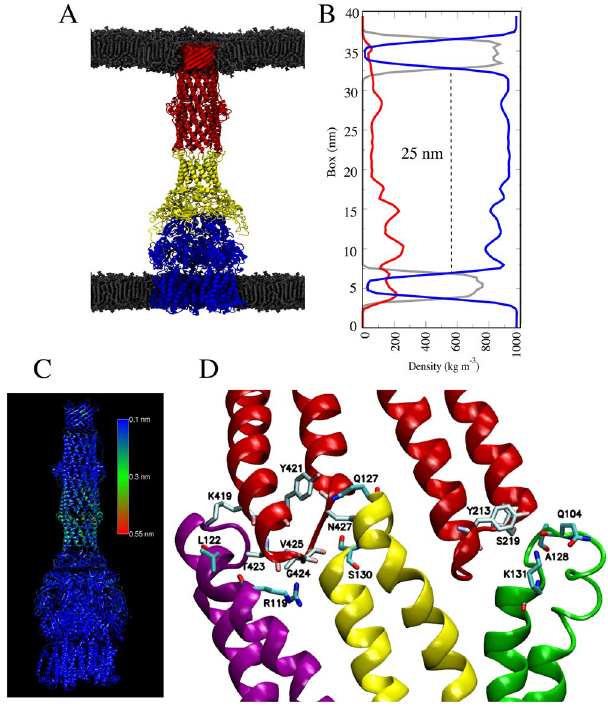
Figure 2. Molecular dynamics simulation of the fully assembled MexAB-OprM efflux pump. ( A ) The tripartite pump (red: OprM, yellow: MexA, blue: MexB) was embedded in two POPC bilayers (gray lipids) to mimic the double membrane bilayers of Gram-negative bacteria. For clarity, water molecules are not shown. ( B ) Mass density profile of the simulated system highlighting the peaks corresponding to the protein structure (red), the POPC lipids (gray), and the water molecules (blue). The density highlights the thickness of the periplasmic region as denoted by the distance between the phosphate groups of the corresponding inner leaflets (25 nm). ( C ) Root mean square fluctuations (RMSF) of the backbone atoms of the whole pump, highlighting higher fluctuations in the contact region between the periplasmic and the outer membrane domains. Fluctuations mostly range between 0.2 and 0.4 nm. ( D ) Close-up of the residues interacting between the periplasmic adaptor and outer membrane proteins during the MD simulation. Note that a single OprM monomer (red ribbons) is able to interact with three periplasmic protomers (green, yellow, and purple